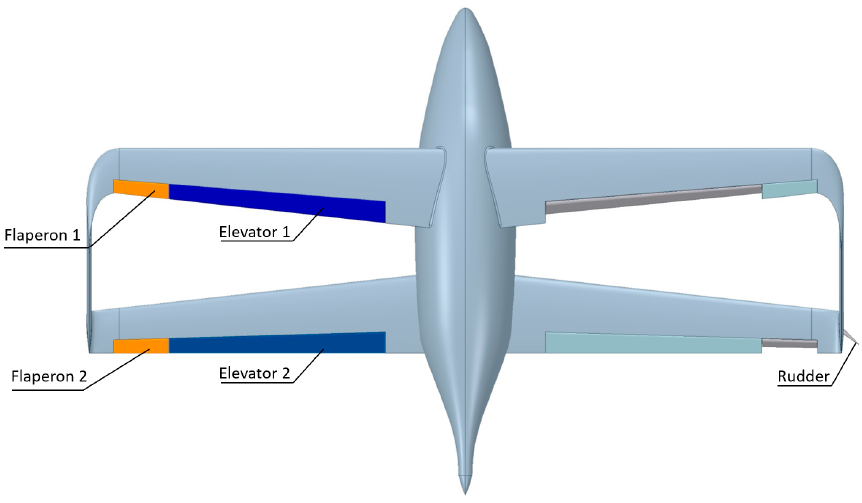
Figure 2. Arrangement of control surfaces on the boxplane wings, geometry taken from [19].